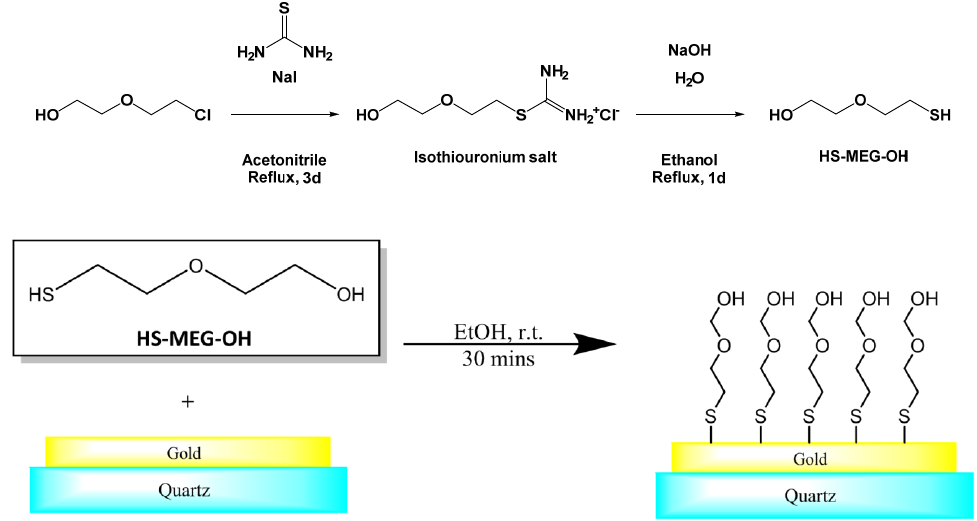
Figure 1. Synthesis and self-assembly of 2-(2-mercaptoethoxy)ethan-1-ol to gold electrodes of a TSM device.